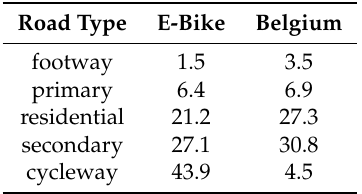
Table 4. A summary of road infrastructure usage.